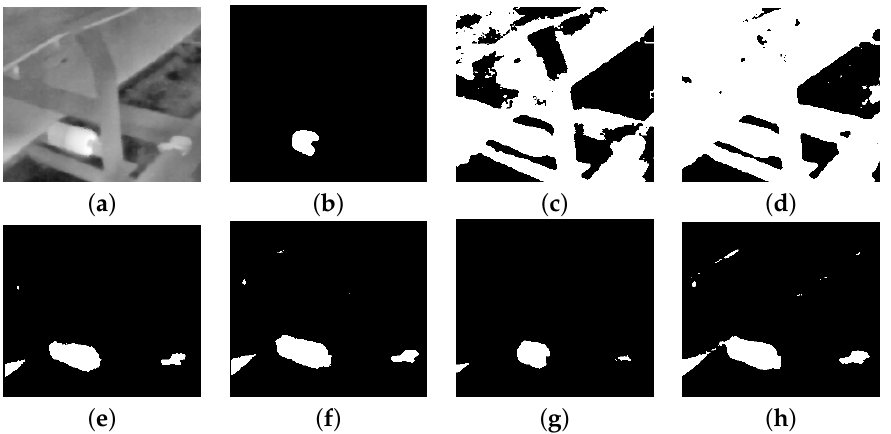
Figure 1. Example results of infrared image segmentation using thresholding method: ( a ) original infrared image, ( b ) ground truth segmentation, ( c ) Shanbhag [24], ( d ) Otsu [25], ( e ) Intermode [26], ( f ) Triangle [27], ( g ) Yen [28], ( h ) Maximum Entropy